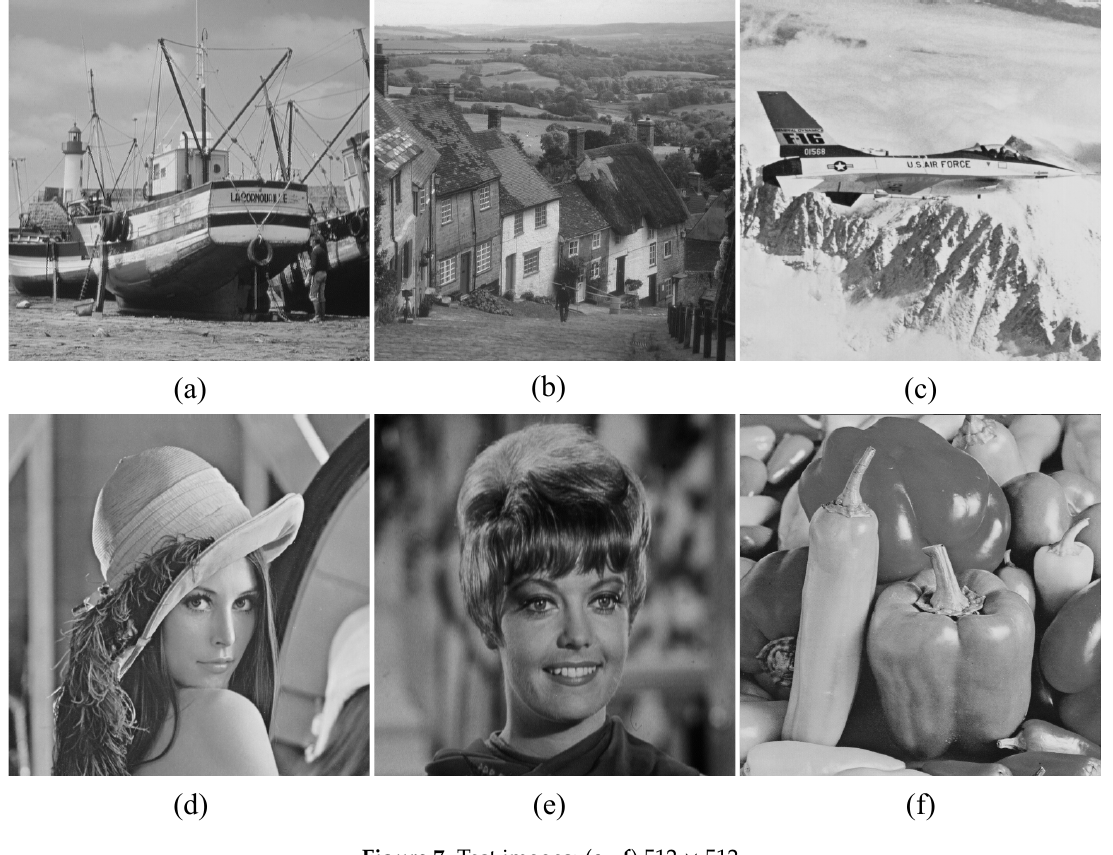
Figure 7. Test images: ( a ∼ f ) 512 ×